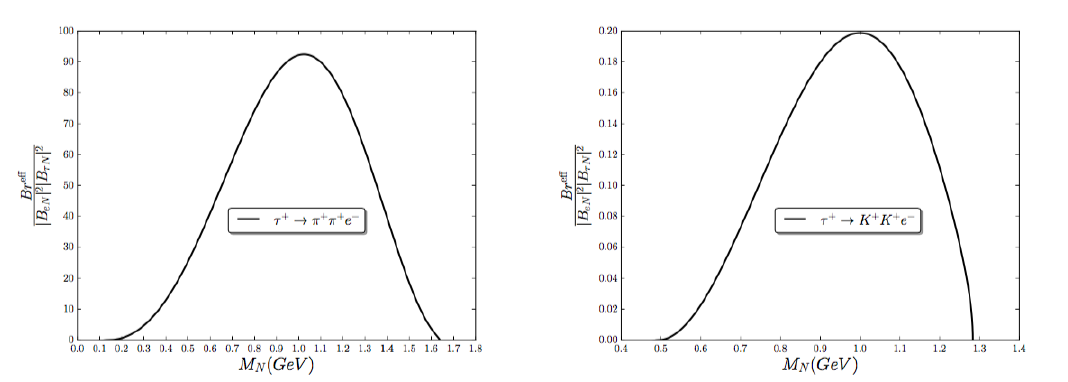
Figure 5 . E(cid:11)ective branching ratios per unit of j B eN j 2 j B (cid:28)N j 2 . Here we use the following input p parameters: cos (cid:18) 12 = 1 = 2, overlap factor (cid:14) 12 = 0 : 5, detector length L = 1 mts, neutrino speed (cid:12) = 1 and Lorentz factor (cid:13) N =